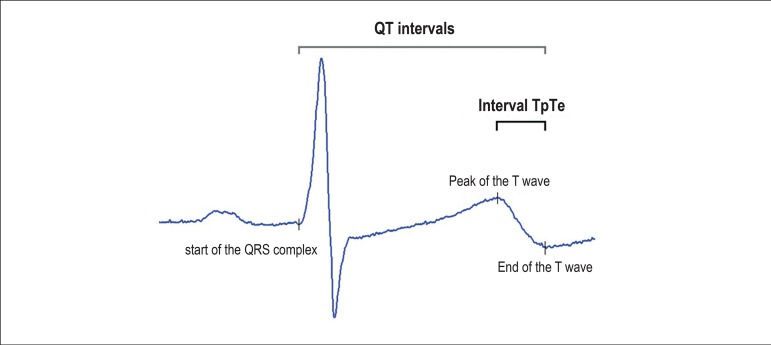
Illustration of the measurements of the QT intervals (interval
between the start of the QRS complex and the end of the T wave) and
TpTe (interval between the peak and the end of the T wave) in a
surface electrocardiogram lead.